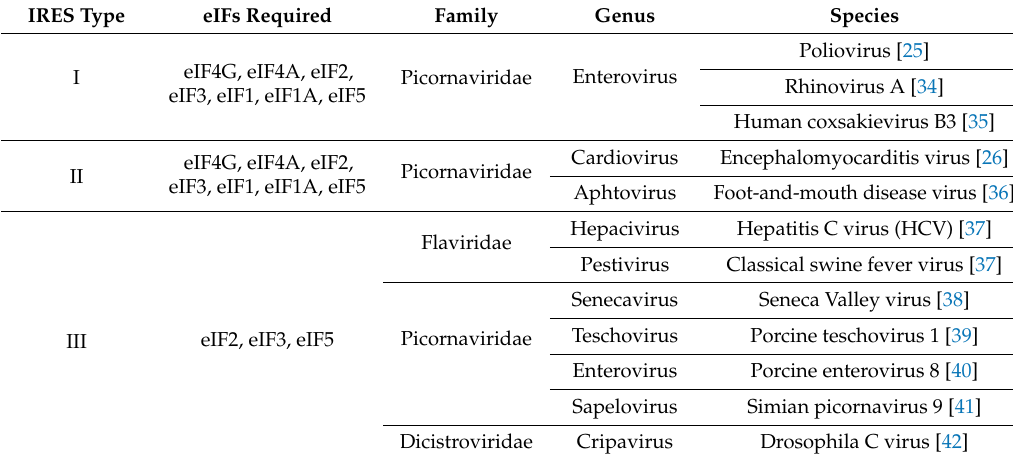
The four main classes of viral IRESs according to their requirement for eIFs (non-exhaustive